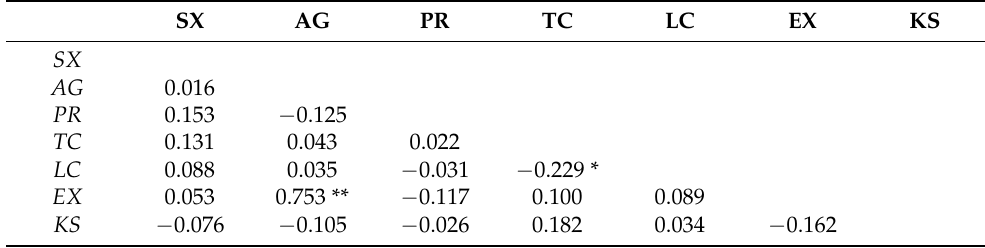
Table A1. Spearman correlation matrix.